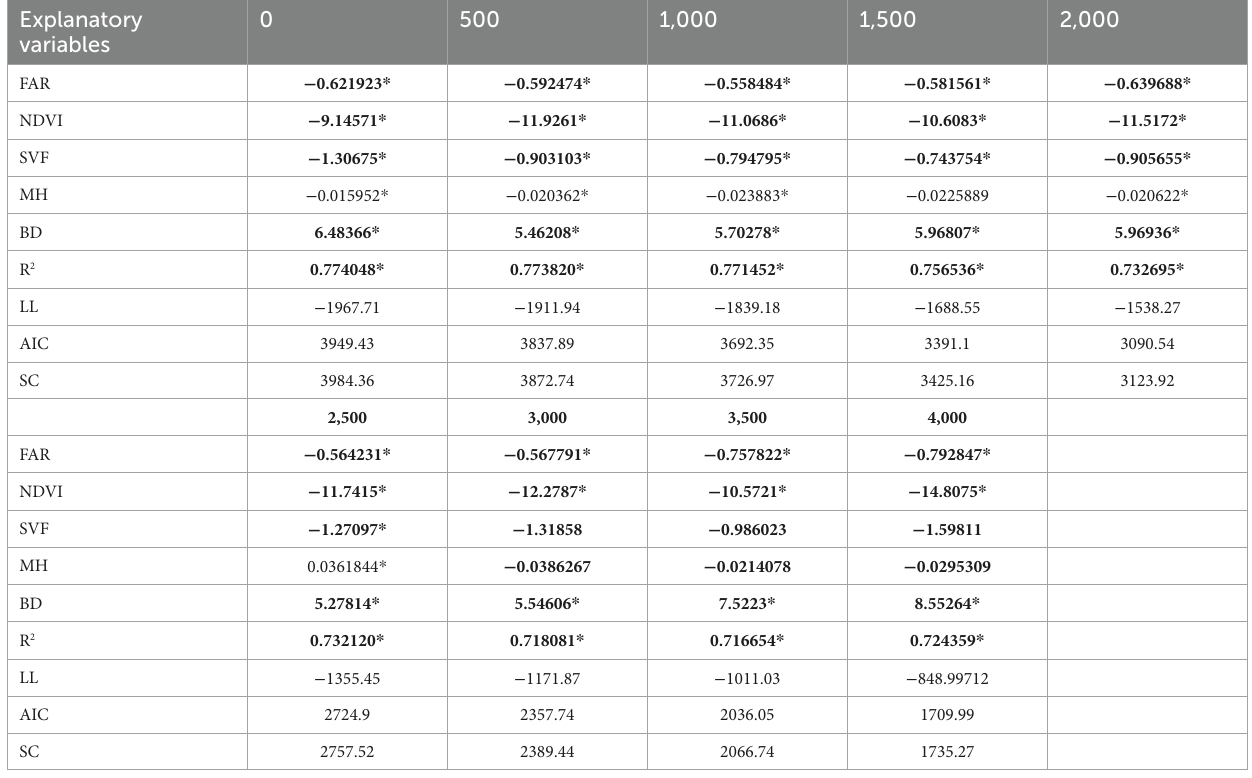
TABLE 3 SLM and SEM model results summary. Explanatory